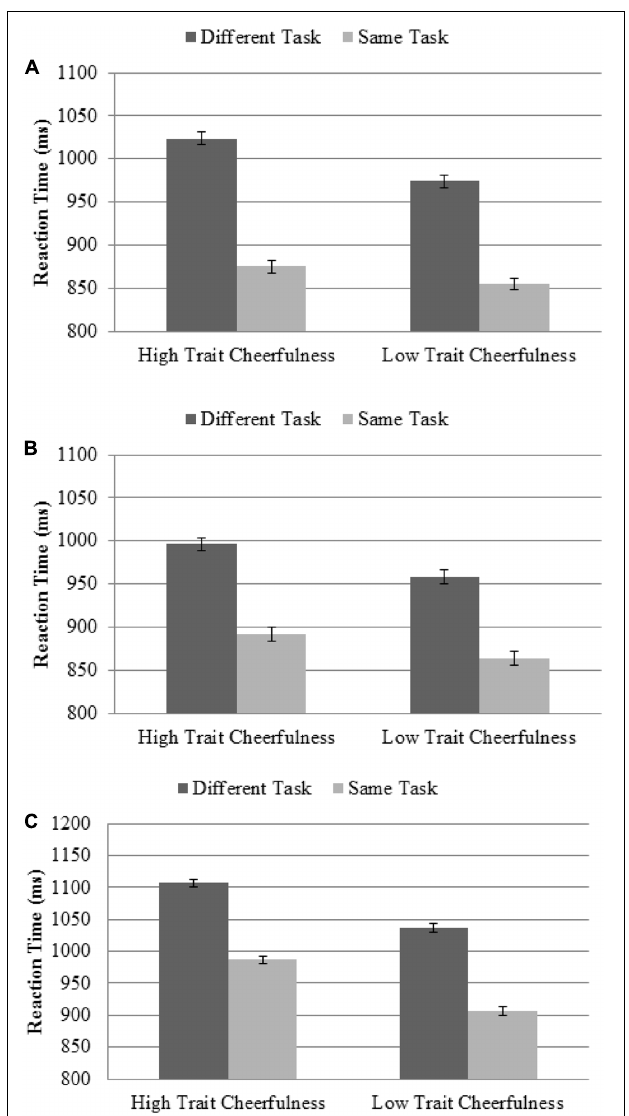
FIGURE 2 | Effect of the task-switching cost as a function of trait cheerfulness group for: (A) Study 1; (B) Study 2, preparation part; and (C) Study 2, no preparation part. Note the lack of differences between both groups. If anything, the general trend is in the opposite direction, as individuals with high trait cheerfulness showed a higher task-switching cost (measured as the difference between a task being repeated or not) than individuals with low trait cheerfulness. The error bars represent the standard error of the mean, with variability between participants removed by means of Coussineau’s method.